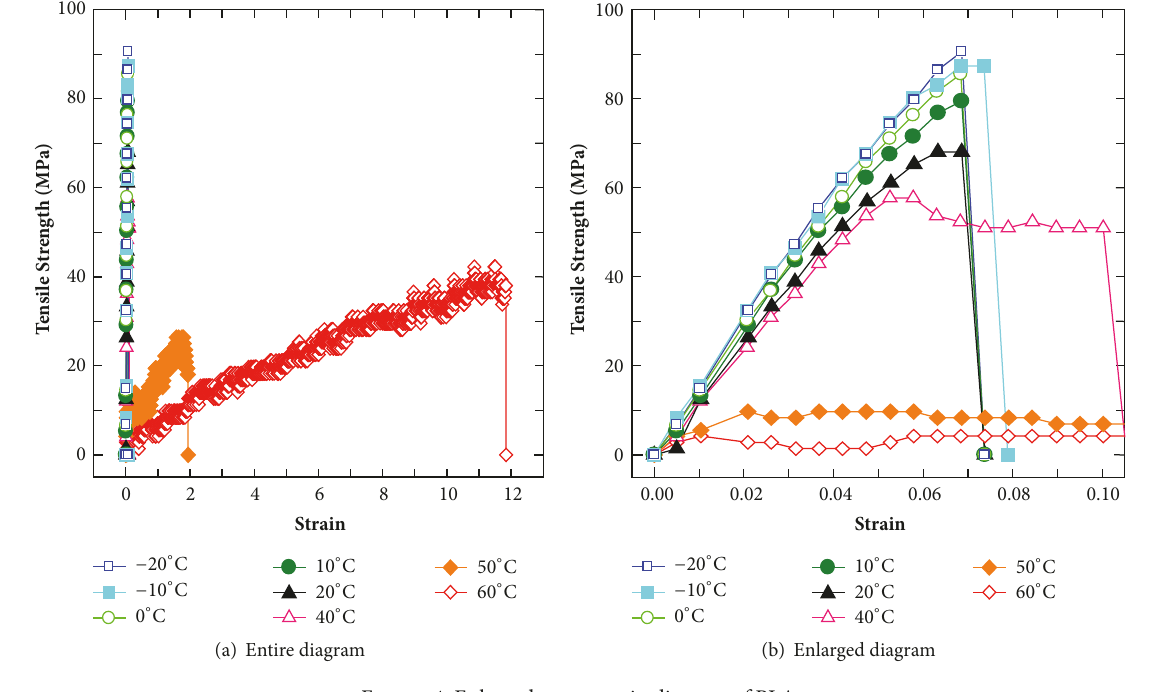
Figure 4: Enlarged stress-strain diagram of PLA.